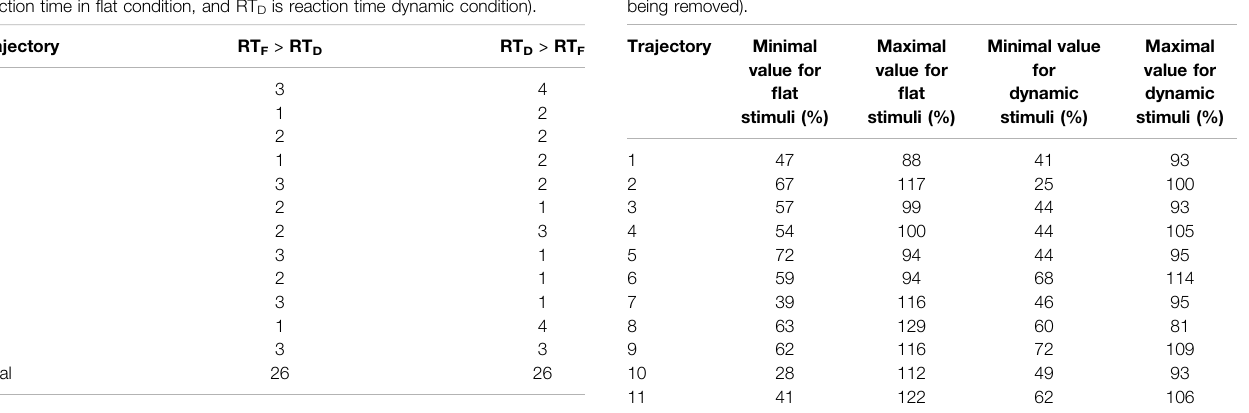
TABLE 3 | Extremal values of the reaction time threshold in each direction (in percent of the subject ’ s arm length and values below 25% and over 150% being